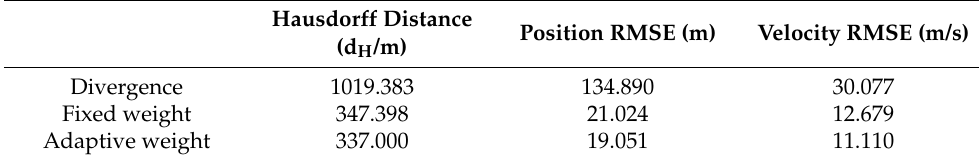
Figure 9. The performance comparisons of the three algorithms in DS1. ( a ) Trajectory. ( b ) Hausdorff distance. ( c ) RMSE of position. ( d ) RMSE of velocity. Table 5. Performance comparisons of the three algorithms in